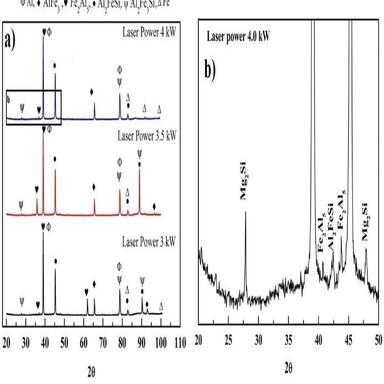
(a) XRD profiles of braze joints with varying laser powers (b) enlarged selected XRD (4 kW power).